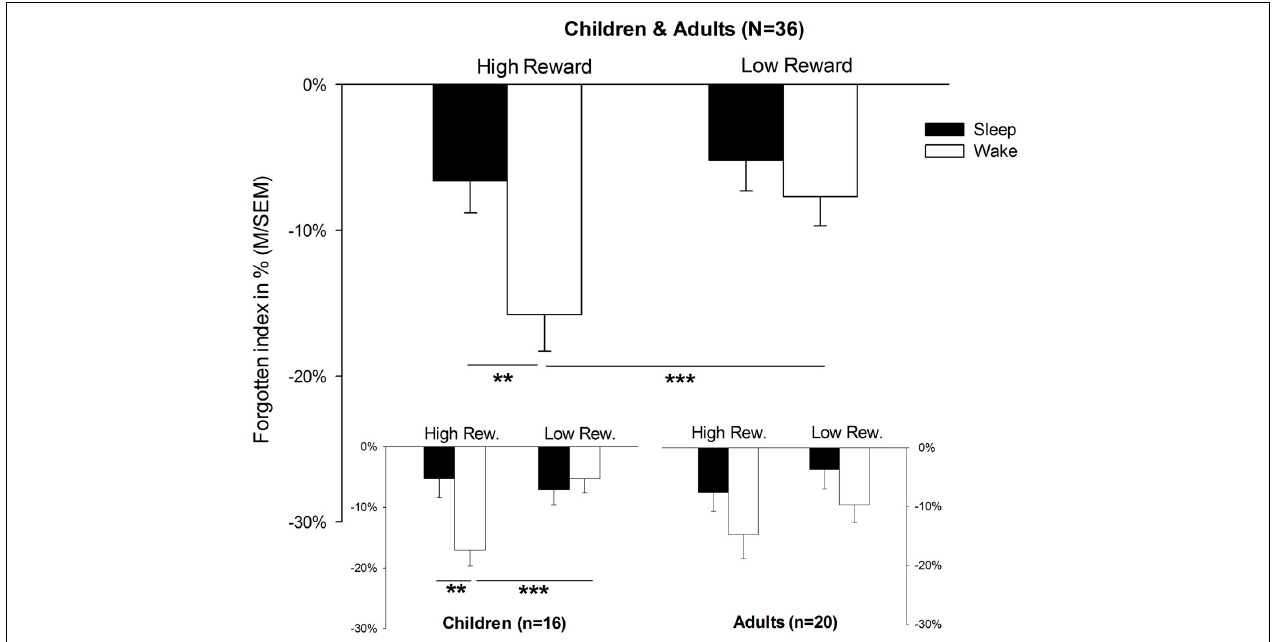
FIGURE 2 | Memory performance. Memory performance in terms of forgetting rates; presented values refer to forgotten object location performance in terms of distance between the correct position and the position indicated by the participant (in %) during the 12 h retention interval either containing sleep or solely wakefulness. Please note that the forgotten index accounts for the distance between the indicated and the correct location. M, mean; SEM, standard error of means; ∗∗ p = 0.01; ∗∗∗ p =